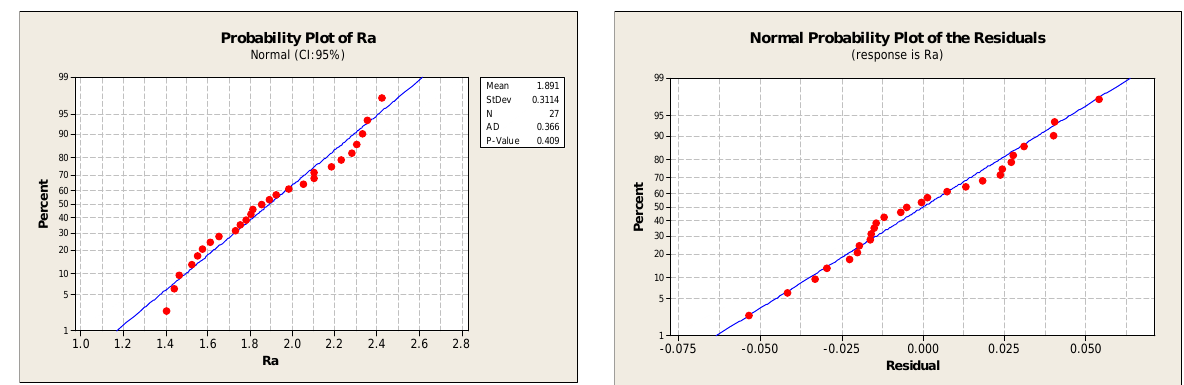
Fig. 3. Anderson Darling test of normality for Ra Fig. 4. Normal probability plot of the residuals for